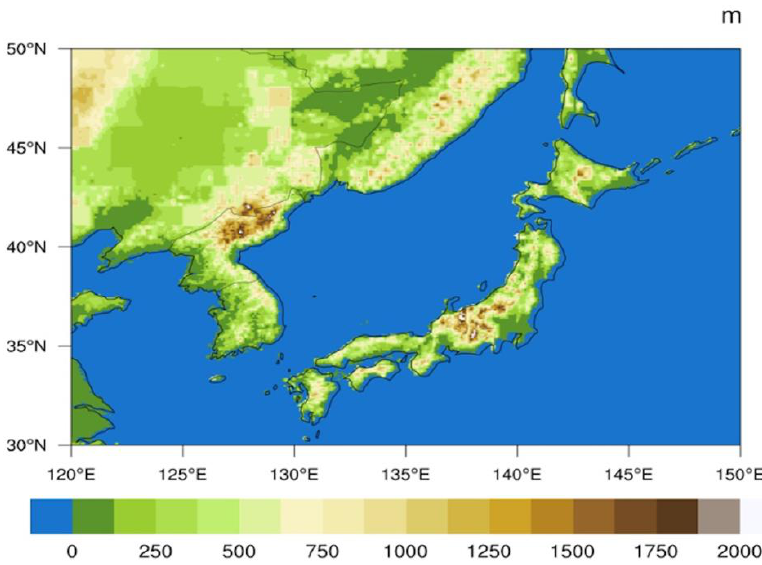
Figure 2. Elevation distribution over the typical region of East Asia. Units are m.